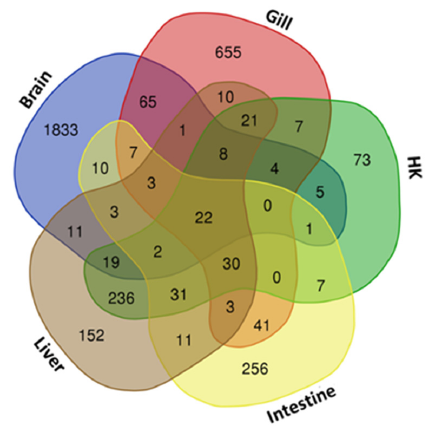
Figure 2. Principal component analysis (PCA) of the genes in all samples: Fold changes in each organ were converted to principal component values and visualized in three-dimensional coordinates, and the head kidney (HK) and liver were located closer to each other than the other organs. Table 2. A total of 22 differentially expressed genes common in five organs of common carp under hypoxic conditions. Sequence ID 1 Gene Symbol